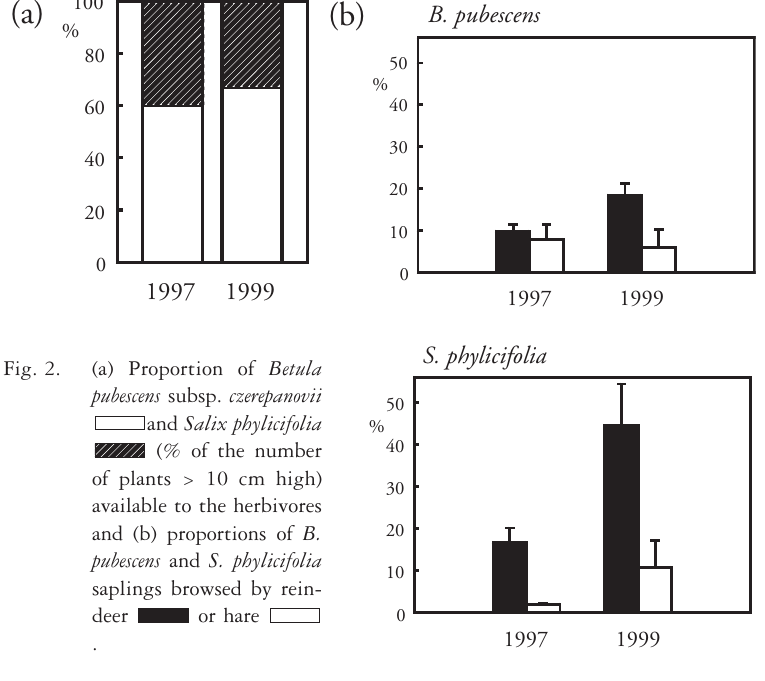
Fig. 2. (a) Proportion of Betula pubescens subsp. czerepanovii and Salix phylicifolia of plants > 10 cm high) available to the herbivores and (b) proportions of